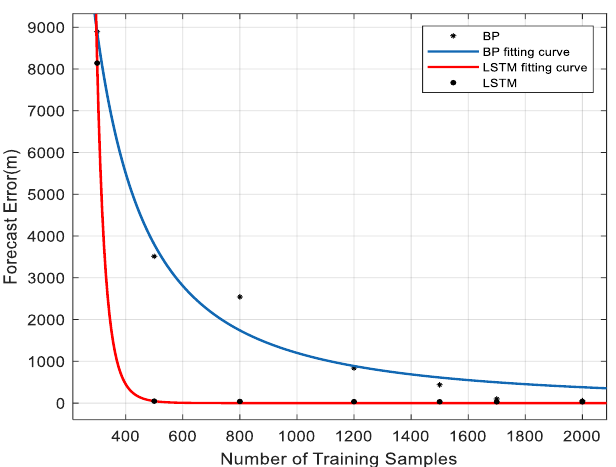
Figure 10. Effect of training sample number on training results.